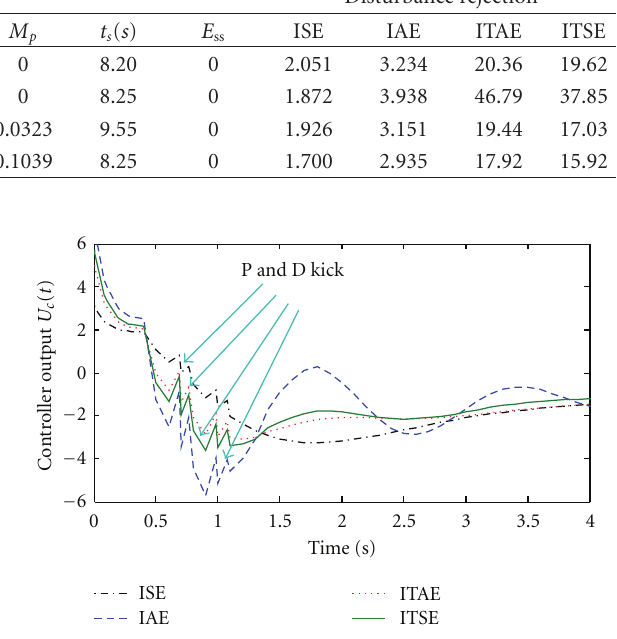
Figure 9: The e ff ect of proportional and derivative kick in U c ( t